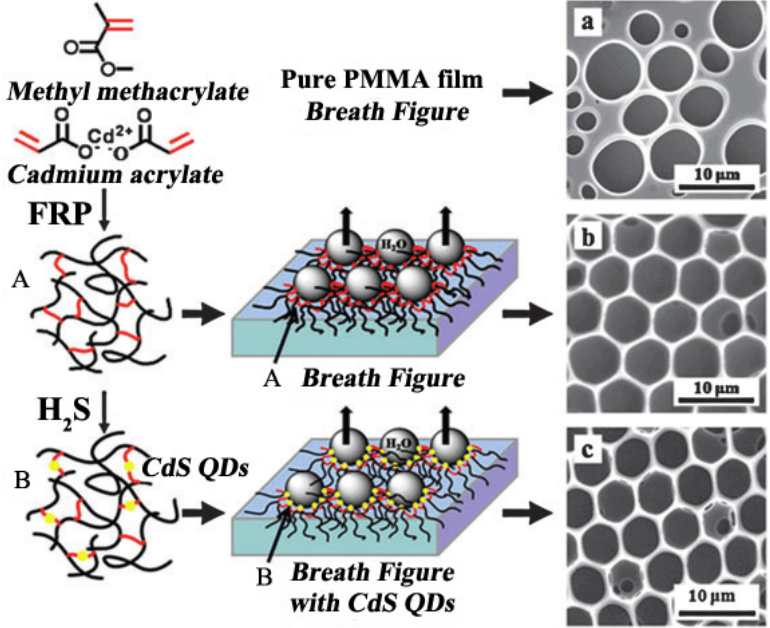
Figure 16. Illustration of the CdS QDs honeycomb film formation process. The initial process is the synthesis of poly(methyl methacrylate)/cadmium acrylate (PMMA/Cd(AA) 2 ) ionomer, and the breath figure process of this ionomer is shown as (A); Then PMMA/CdS QDs was formed by exposing the ionomer to an H 2 S atmosphere, and the QD-polymer honeycomb film formation is shown as (B). The SEM images formed by these breath figure process are shown in (a) for pure PMMA film, (b) for PMMA/Cd(AA) 2 ionomer film and (c) for PMMA/CdS QD-polymer film. Here, the solvent is CHCl 3 , polymer concentration = 6.7 wt%, Cd 2+ /S 2- = 1:0.33 mol mol -1 , humidity = 85%. The copyright permission was from reference